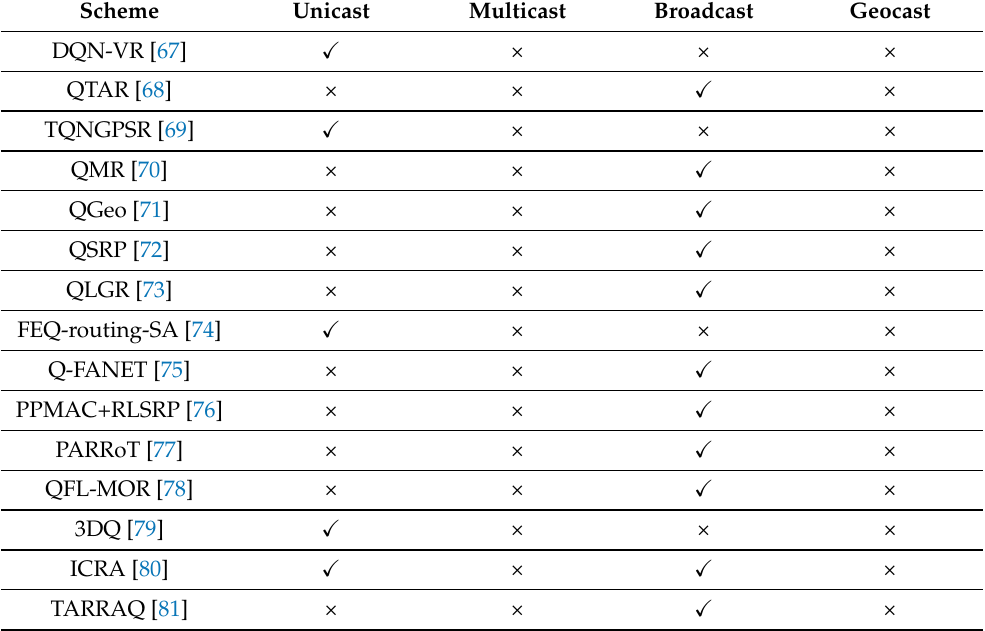
Table 32. Comparison of RL-based routing methods based on the data dissemination